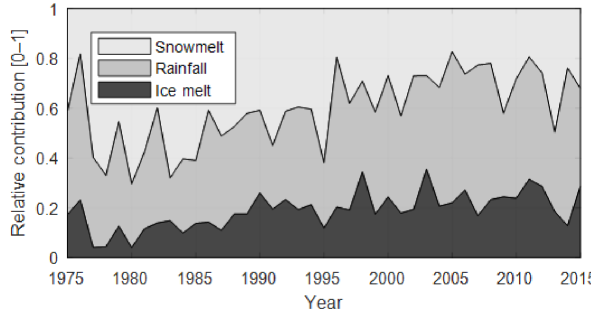
Figure 10. Relative contribution of snowmelt (SM), rainfall ( R ), and ice melt (IM) for the summer months July–August, computed as the ratio between each component and their sum. Rainfall is ex- tracted from observed precipitation by using a rain–snow tempera- ture threshold, snow and ice melt are simulated with spatially dis- tributed temperature-index